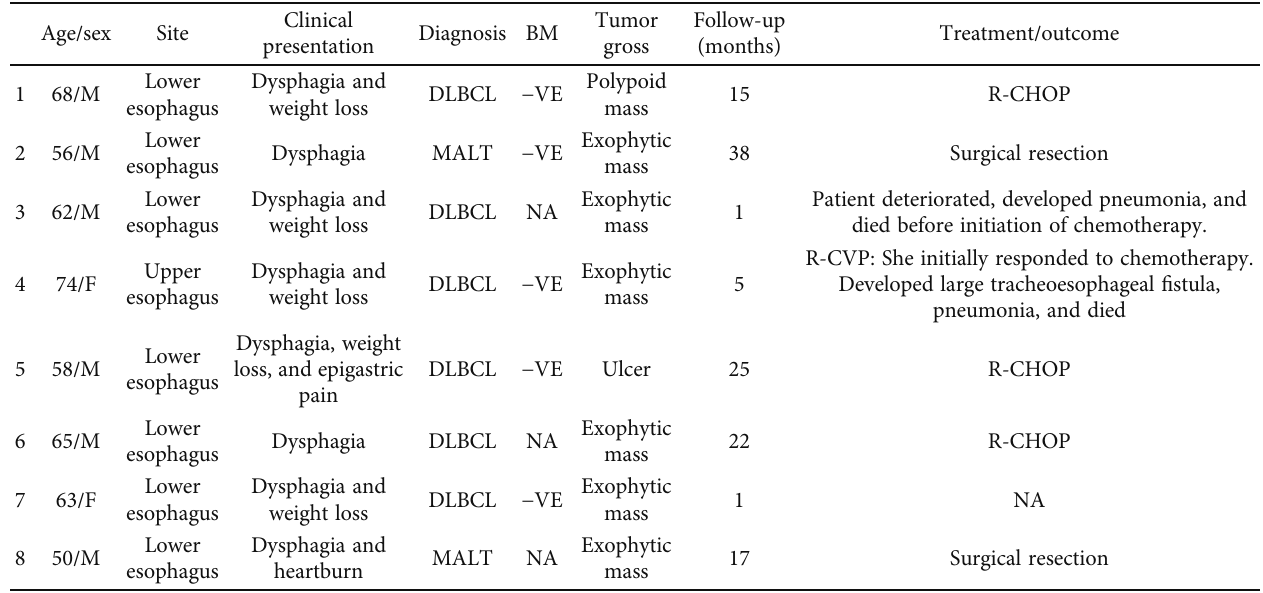
Table 1: Summary of the PEL cases diagnosed at KAUH and KFSH&RC,